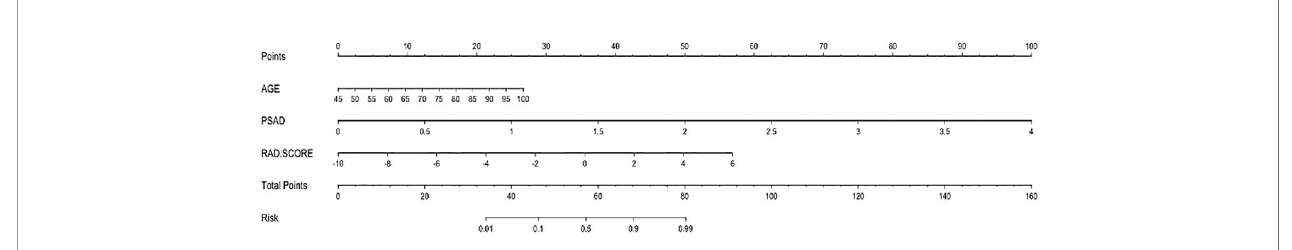
FIGURE 6 | Nomogram of the combined model for predicting PCa.